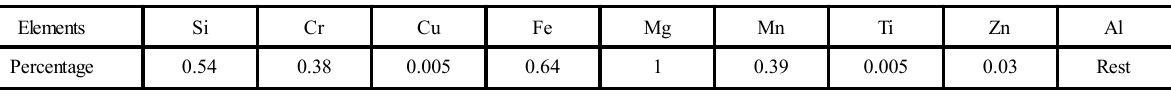
TABLE 2. CHEMICAL COMPOSITION OF